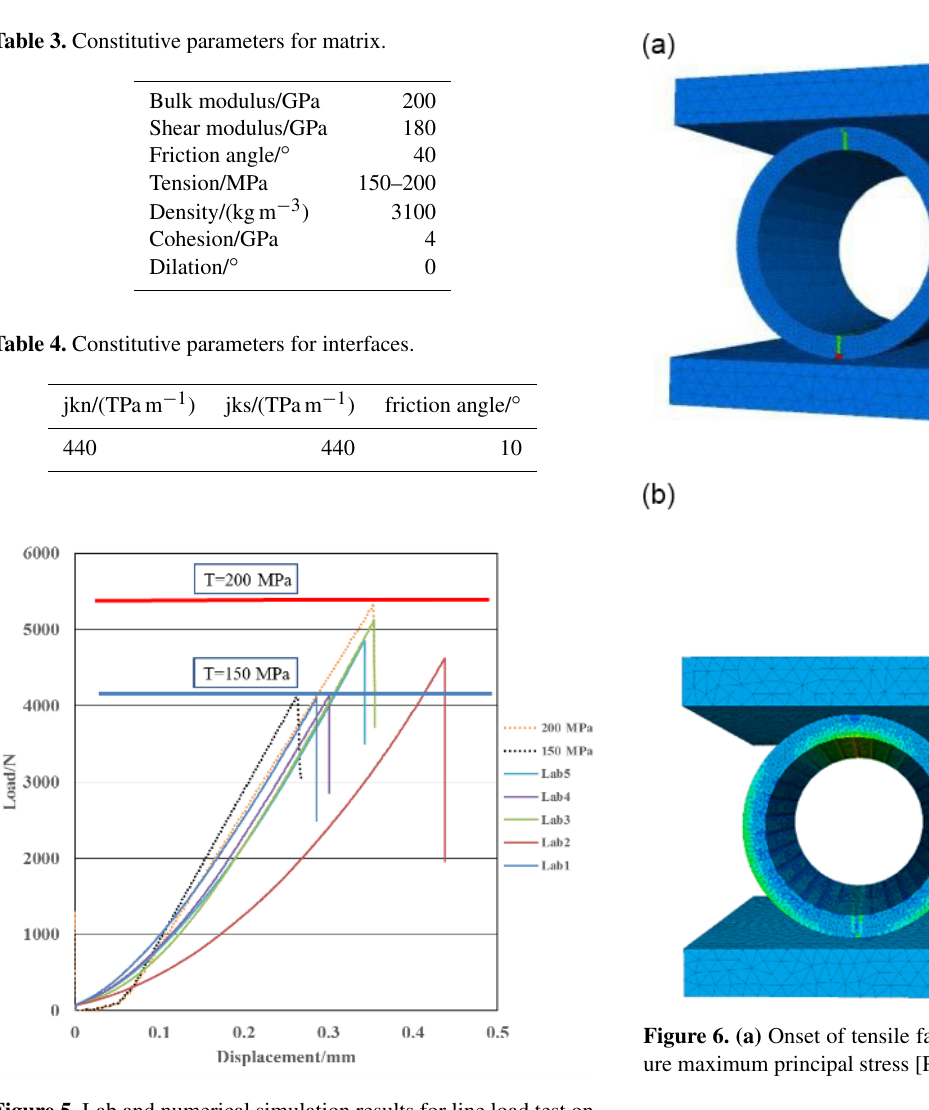
Figure 5. Lab and numerical simulation results for line load test on hollow cylinder according to Fig. 6 (loading rate 0.004mms − 1 ).